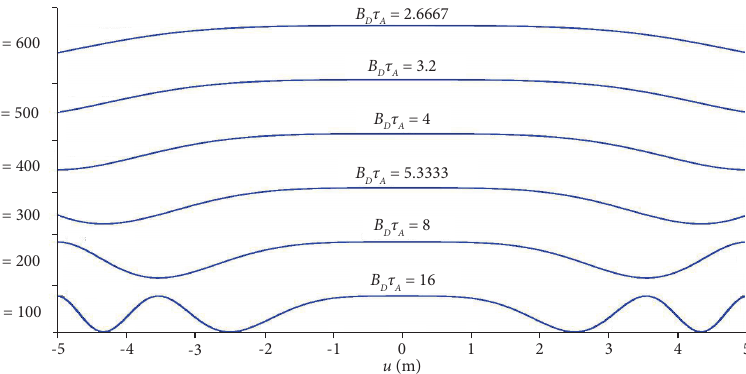
D for several point targets at the NR. 0 τ ) and illumination time ( τ ), the product ( B ) is very small compared to D A D A